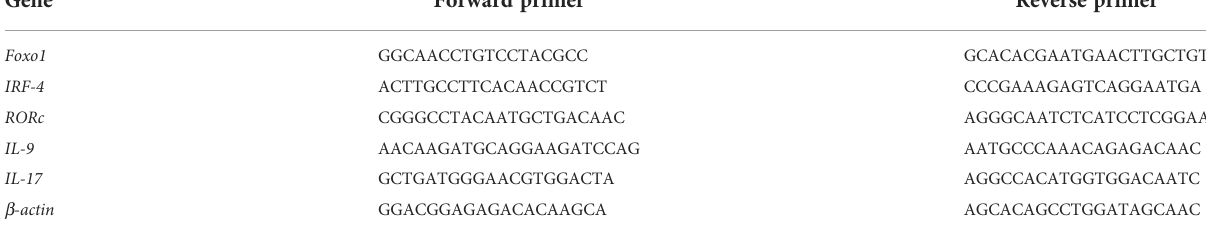
TABLE 1 Primers used for real-time PCR